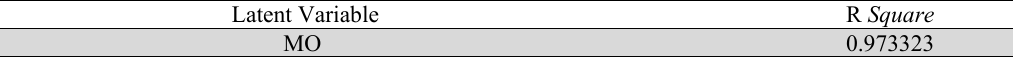
Recapitulation of R 2 Latent Variable R Square MO 0.973323